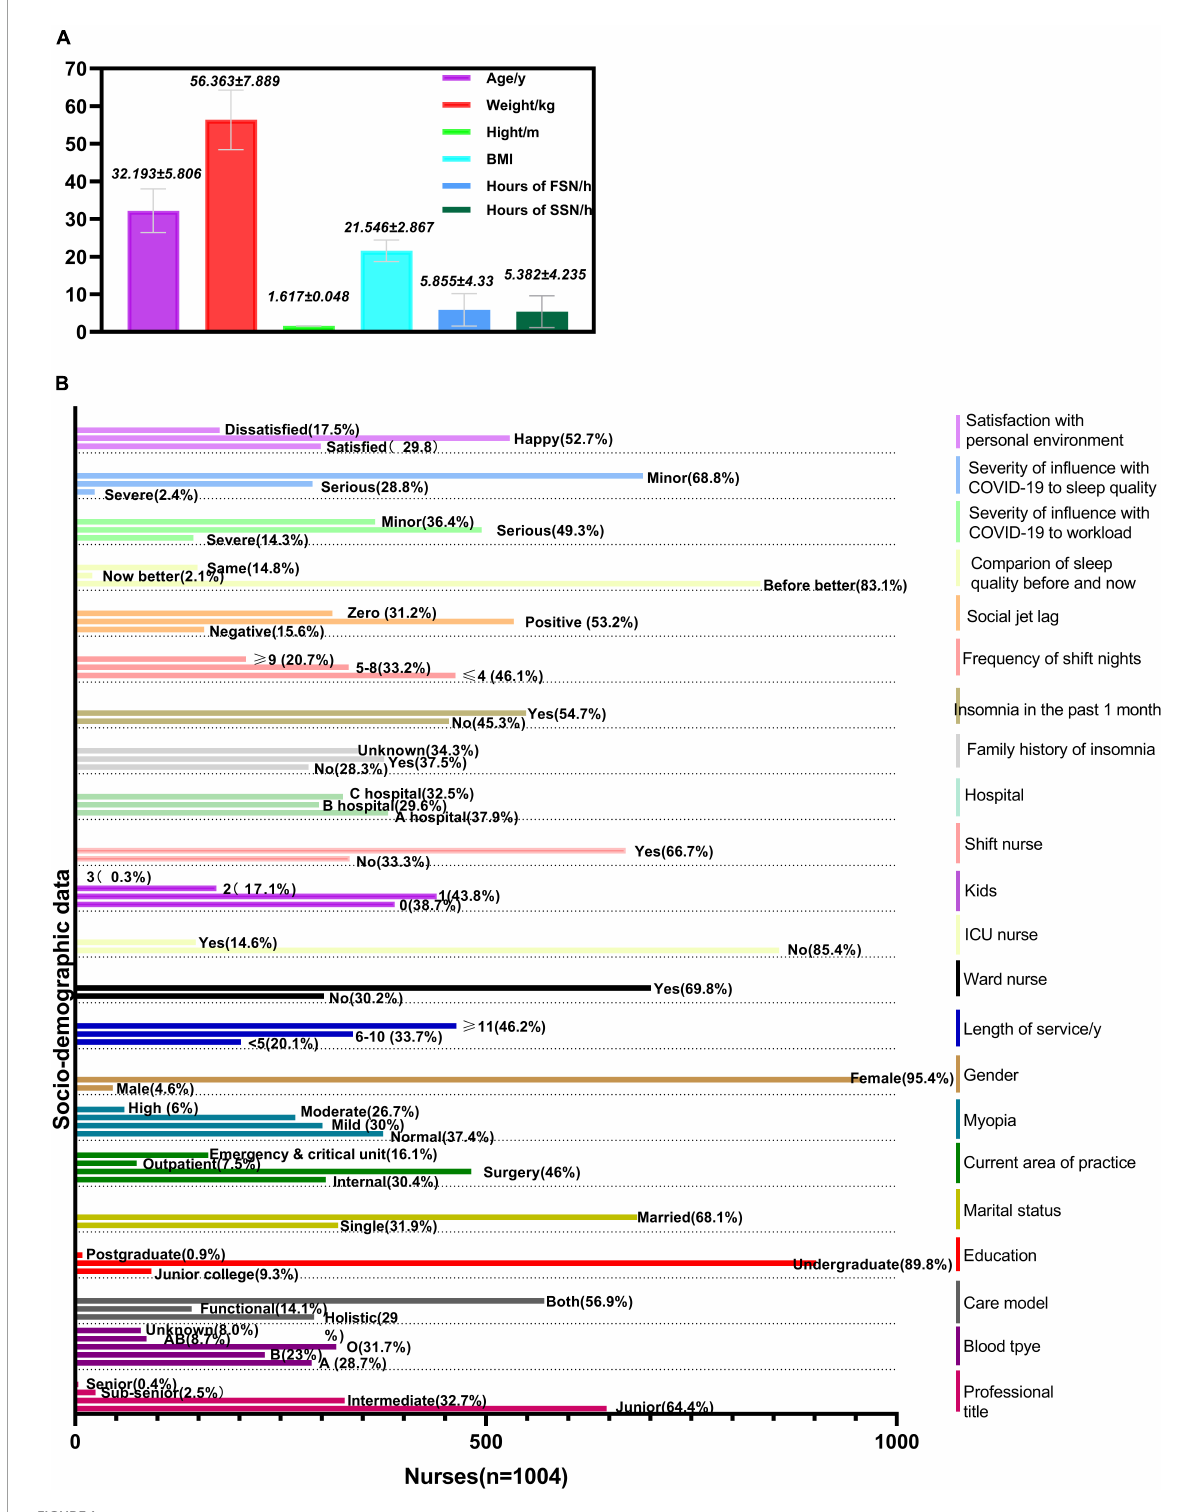
FIGURE1 Descriptive analysis of sociodemographic data ( n = 1004). FSN, first shift night; SSN, second shift night. (A) The mean and standard deviation of demographic data of nurses. (B) The percentage of nurses on socio-demographic